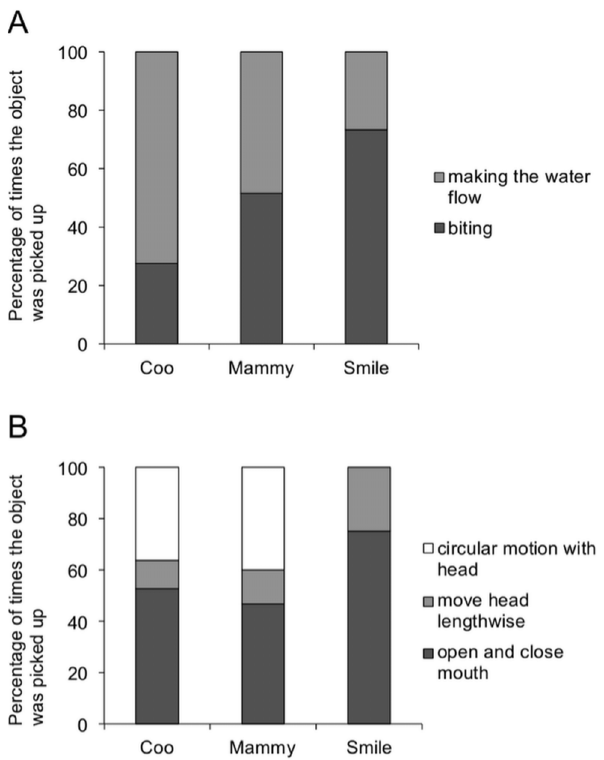
Figure 2. Object pick-up method. (A) The ratio of biting or making the water flow when picking up the object in relation to the total number of times it was dropped. (B) The ratio of each method of creating water flow out of the total number of times the water flow was created for each individual. The legend indicate the method used to make the water